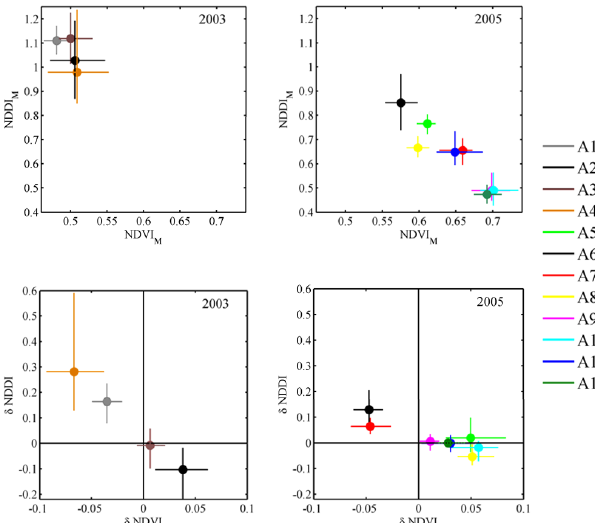
Fig. 5. Dispersion diagrams of centroids corresponding to the pairs NDVI M , NDDI M (top panel) and δ NDVI, δ NDDI (bottom panel) corresponding to the period from February to July 2005, for the area surrounding burnt scars of 2003 (left panel) and for the burnt scars of 2005 (right panel) fire seasons. Coordinates of the centroids are identified by filled circles in the dispersion diagrams, whereas hor- izontal and vertical bars indicate the interquartile ranges. Colours indicate selected scars of 2003: A1 (grey), A2 (black), A3 (brown), A4 (orange); and those of 2005: A5 (light green), A6 (black), A7 (red), A8 (yellow), A9 (magenta), A10 (cyan), A11 (blue), A12 (dark